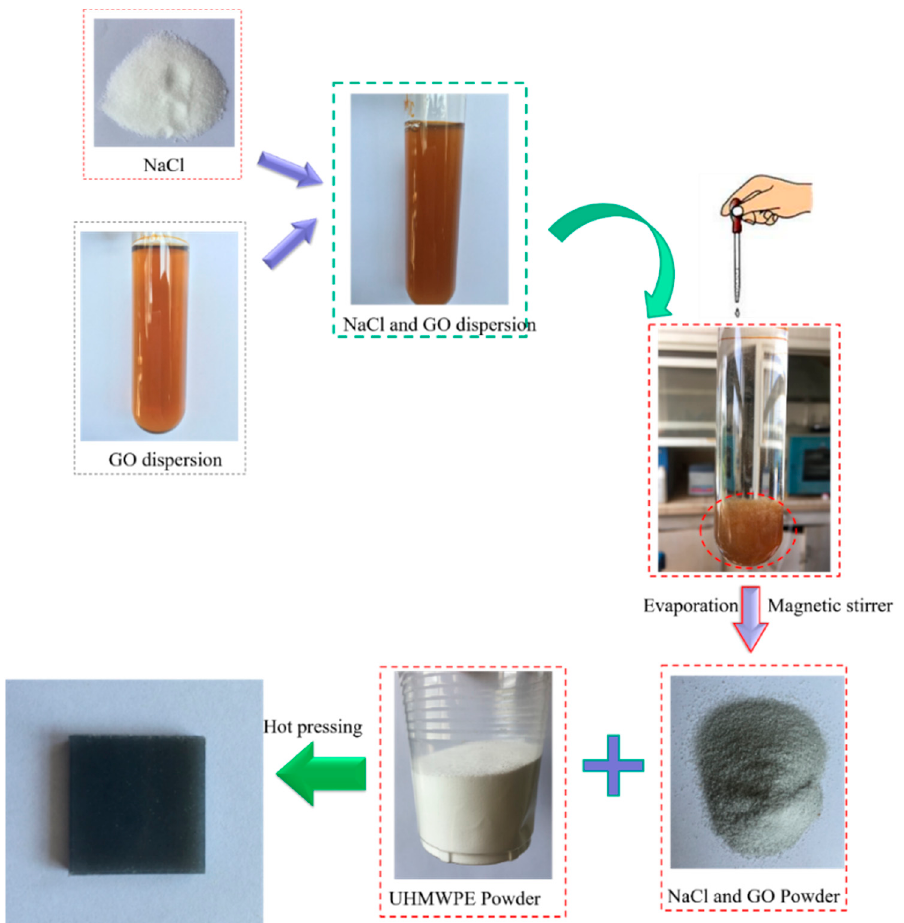
Figure 1. Schematic representation of the fabrication of surface porous graphene oxide (GO)/NaCl/ ultrahigh molecular weight polyethylene (UHMWPE) composites. Table 1. Mass ratios of surface porous GO/NaCl/UHMWPE composites.